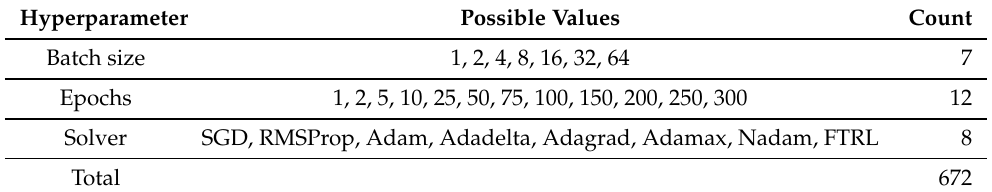
Table 1. Hyperparameter values used in the